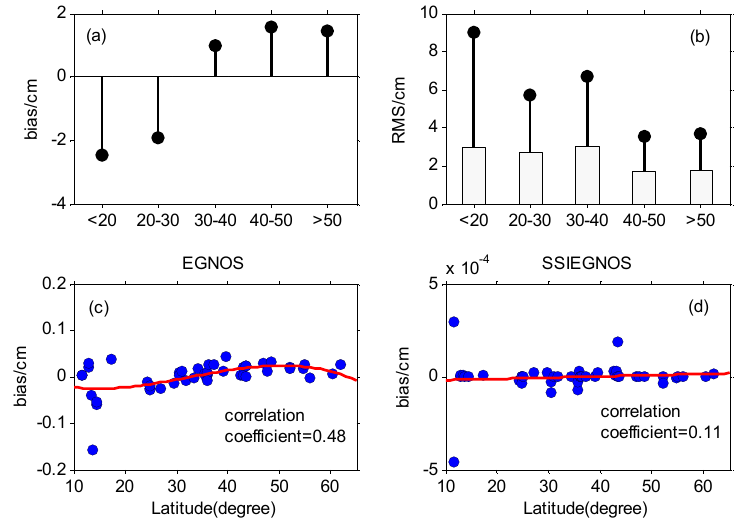
Figure 7. ( a , b ) show the annual bias and RMS error in each latitude range; ( c , d ) show the correlations between bias and latitude, respectively. Black stems and white bars denote the mean bias and RMS error of the EGNOS and SSIEGNOS models, respectively.